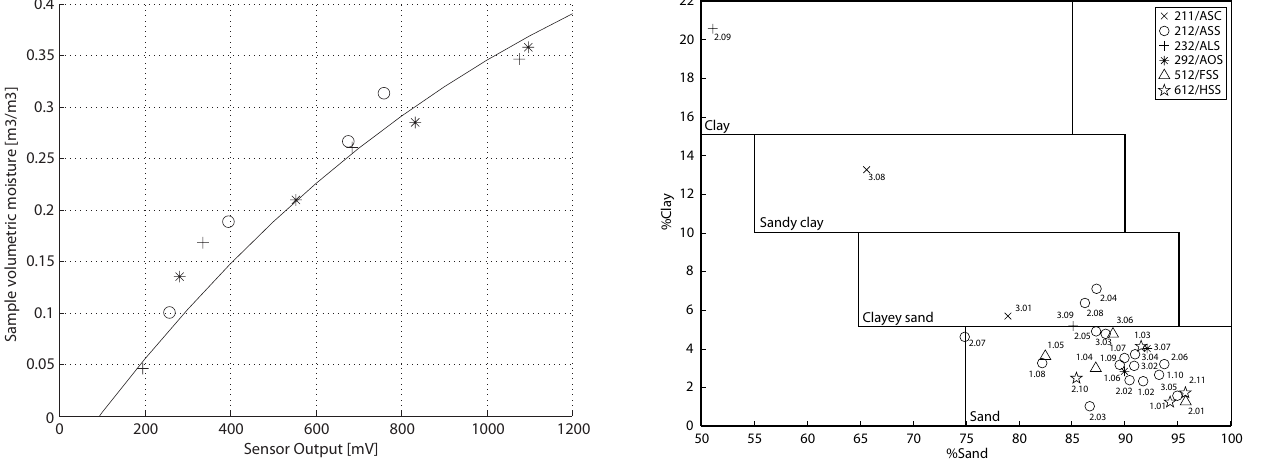
Fig. 7. Soil texture data (sand-% vs. clay-% of 0–5cm depth) per network station according to the composite classes. Discrimination of zones corresponding to the Danish soil grid (Greve et al., 2007) is also